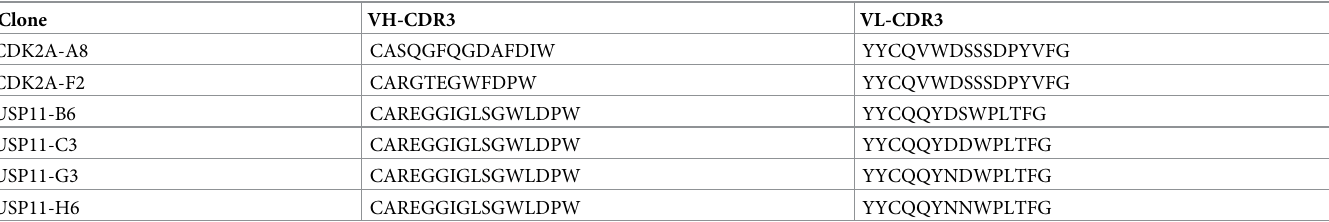
Table 4. VH and VH -CDR3 amino acid sequences of monoclonal scTGPs that recognize CDK2A and USP11.